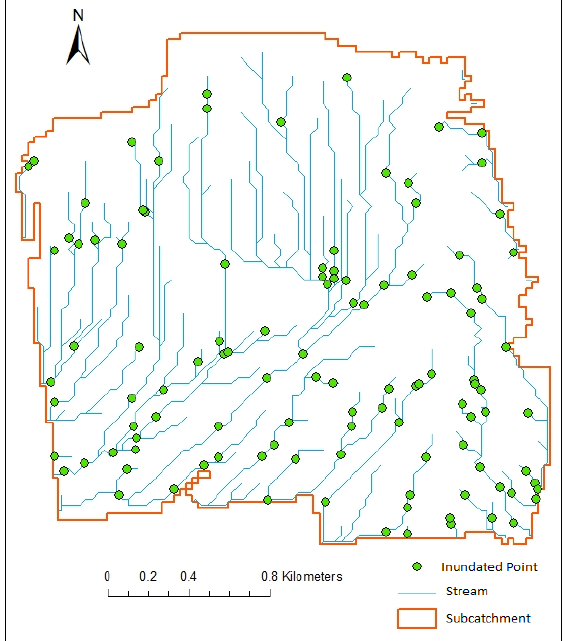
Figure 6. Inundated points, streams, and the sub catchment of the study area calculated by the storm inundation calculation